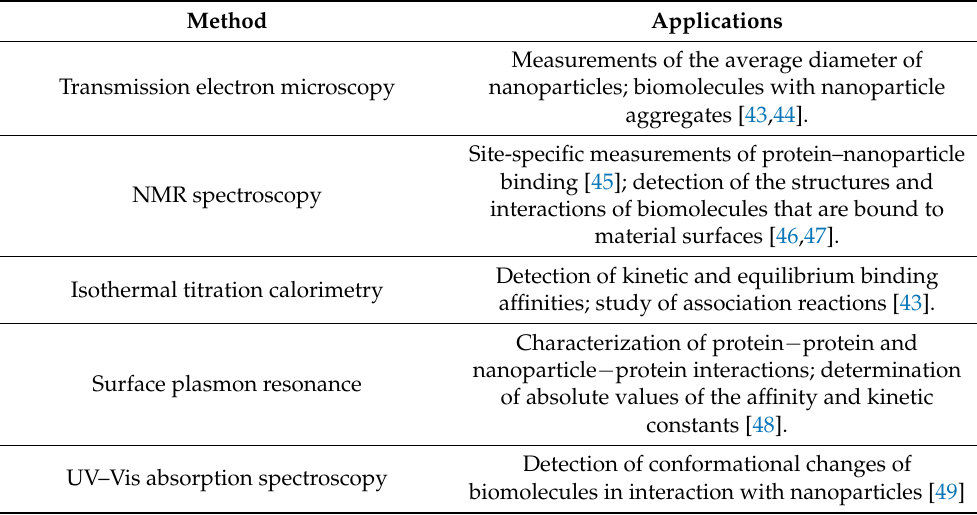
Table 1. Methods of biomolecule–nanoparticle binding